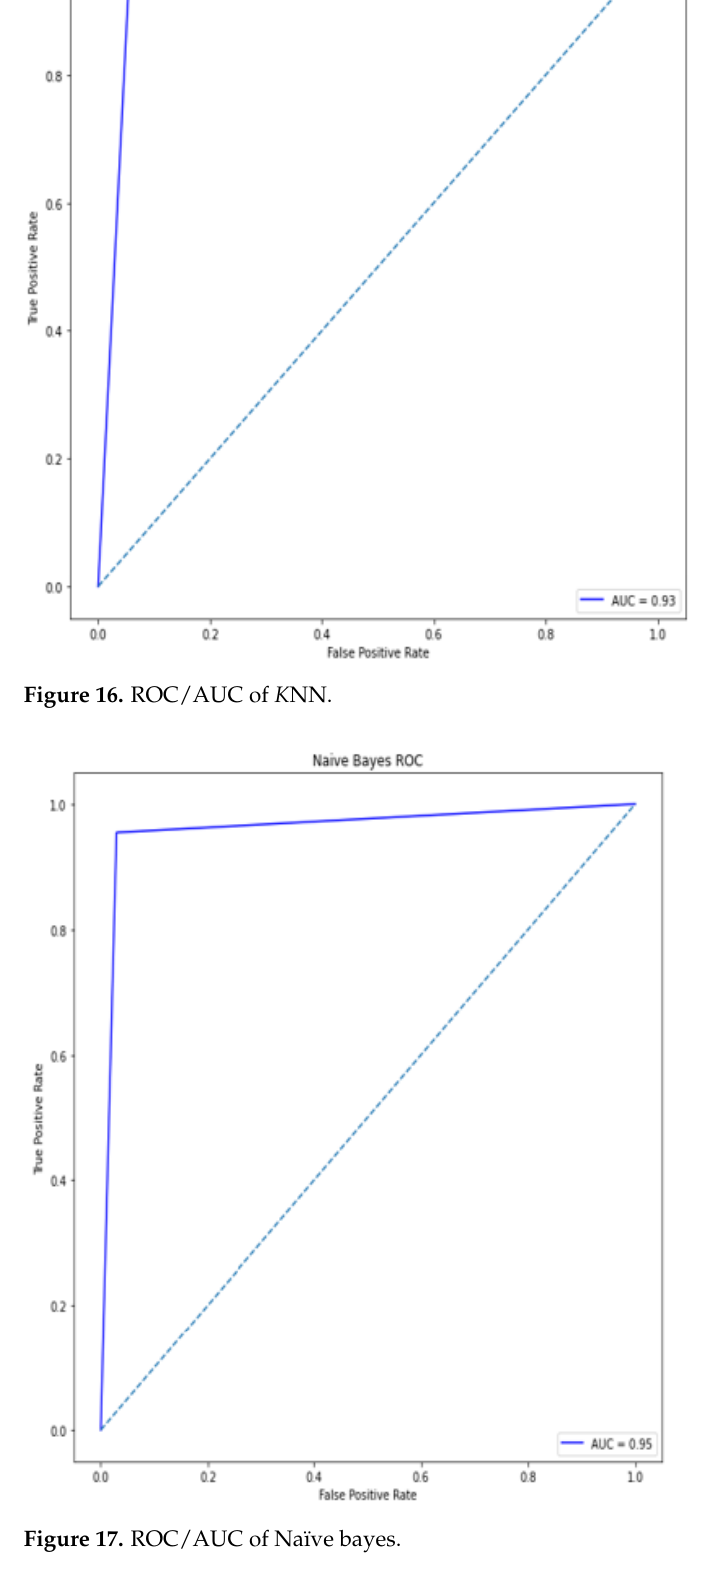
Figure 17. ROC/AUC of Naïve bayes.